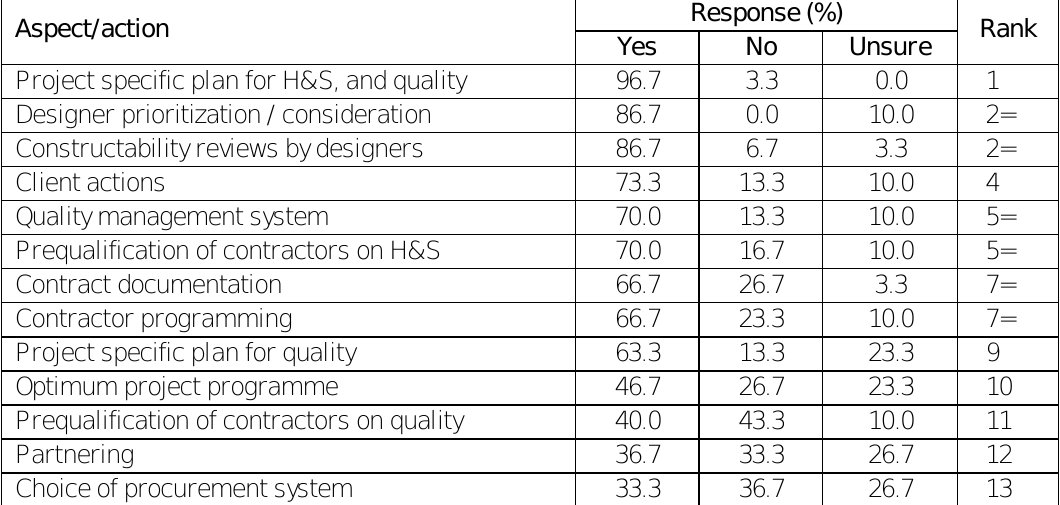
Table 6: Extent to which various aspects/actions can contribute to an improvement in H&S performance according to PMs